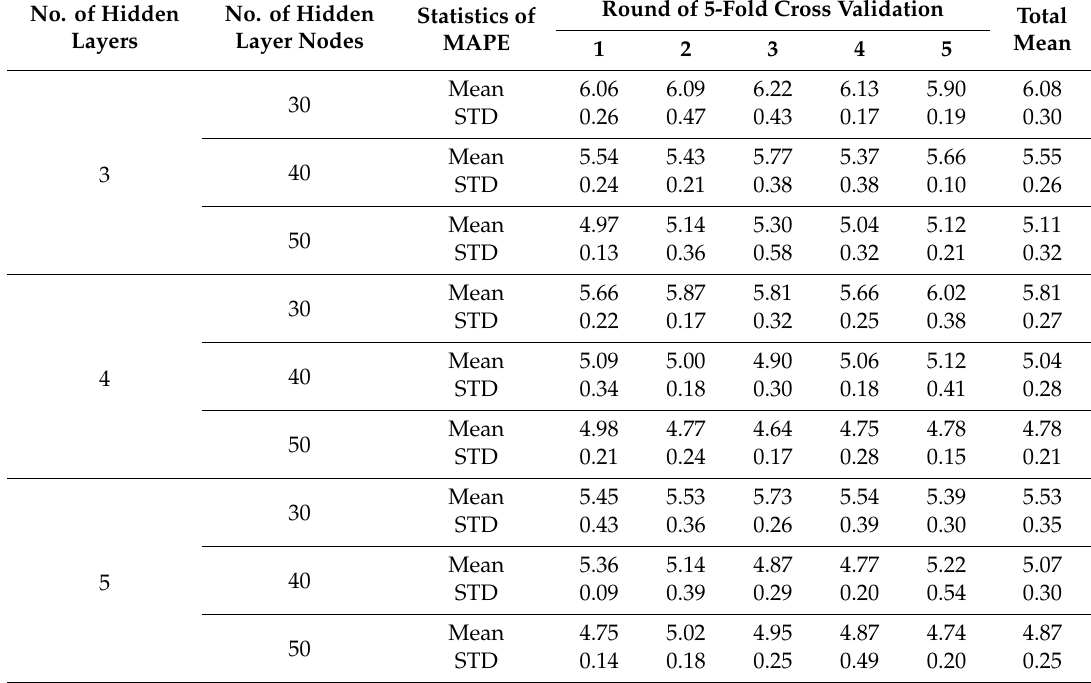
Table 6. Statistical analysis results of mean absolute percentage error (MAPE) of DNN models for predicting morning ore production according to the number of rounds of 5-fold cross validation. No. of Hidden Layers